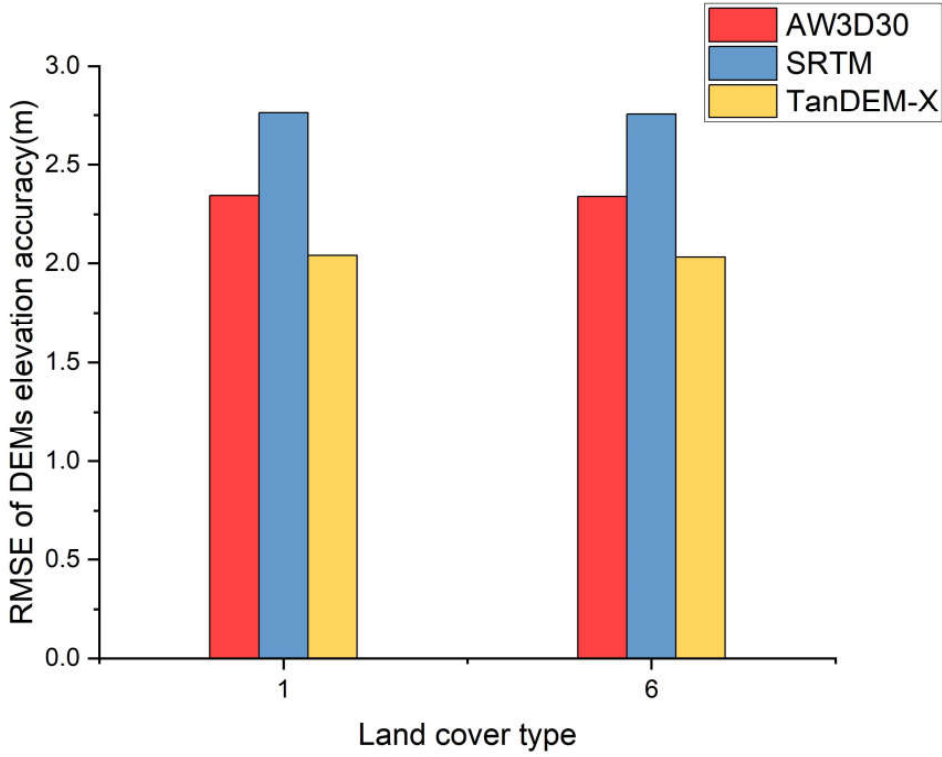
Figure 6. Histograms of RMSE for three DEMs classified by land cover type across all study areas: AW3D30, SRTM, and TanDEM-X.